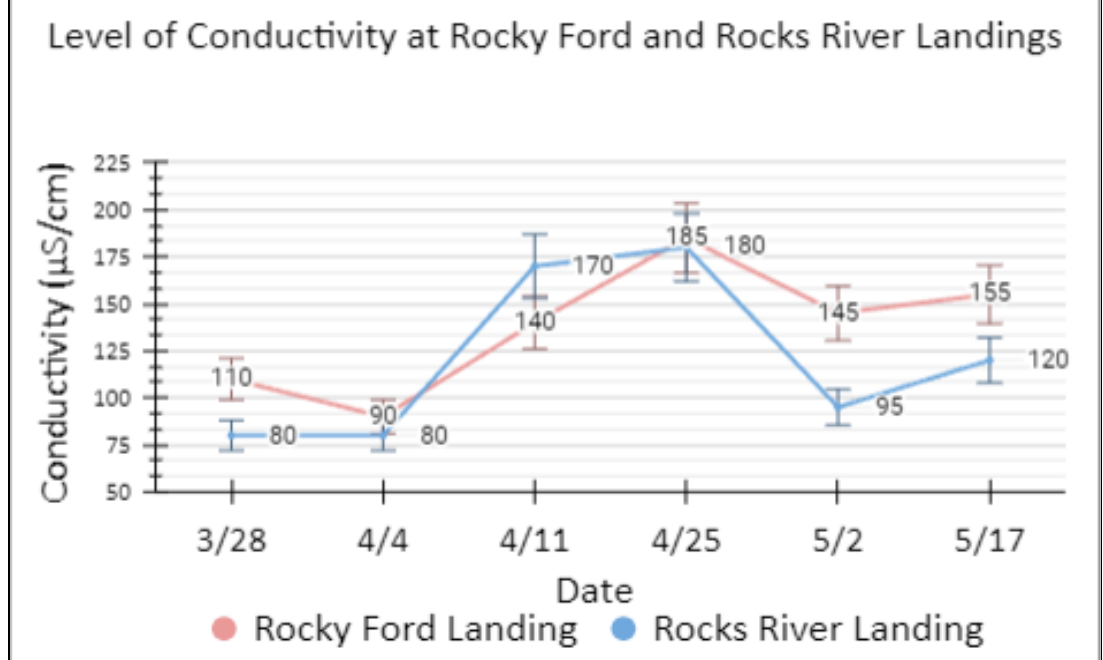
Figure 11. Water Quality — Level of Conductivity from March – May 2022.